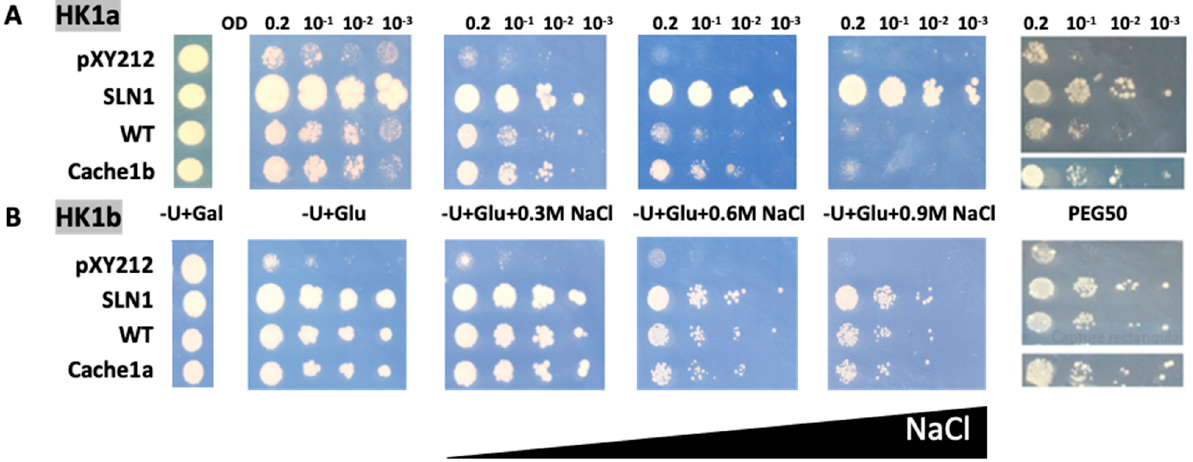
Figure 4. Functional complementation test for cache domain exchange mutants of HK1a ( A ) and HK1b ( B ) in presence of NaCl or PEG 6000 stresses. The osmodeficient strain (MH179) was transformed with the negative (pYX212 empty vector) and positive (SLN1) controls, as well as with wild type constructs (WT) and cache domain exchange constructs (HK1a: cache1b residues 121–437 and HK1b: cache1a residues 121–445). Transformants were spotted onto galactose containing medium ( − U + Gal) for growth control and onto glucose containing medium ( − U + Glu), without or with increasing NaCl concentrations (0.3, 0.6 and 0.9 M) or infused PEG 6000 50% w / v (PEG50), for osmotic tolerance test. Growth tests are representative of four independent replicates as serial 10-fold dilutions from an OD 600 = 0.2, as indicated.